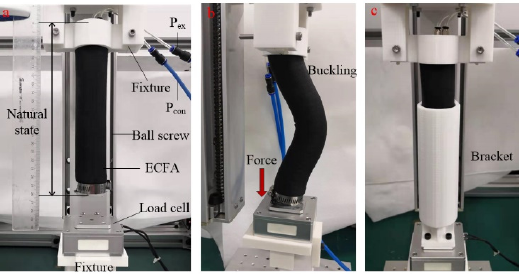
Figure 7. Test the output force of ECFA. ( a ) Calculating the force of the ECFA. ( b ) Buckling of the ECFM when was pressurized. ( c ) calculating the extension force of the ECFA with a 3D-printed rigid bracket.